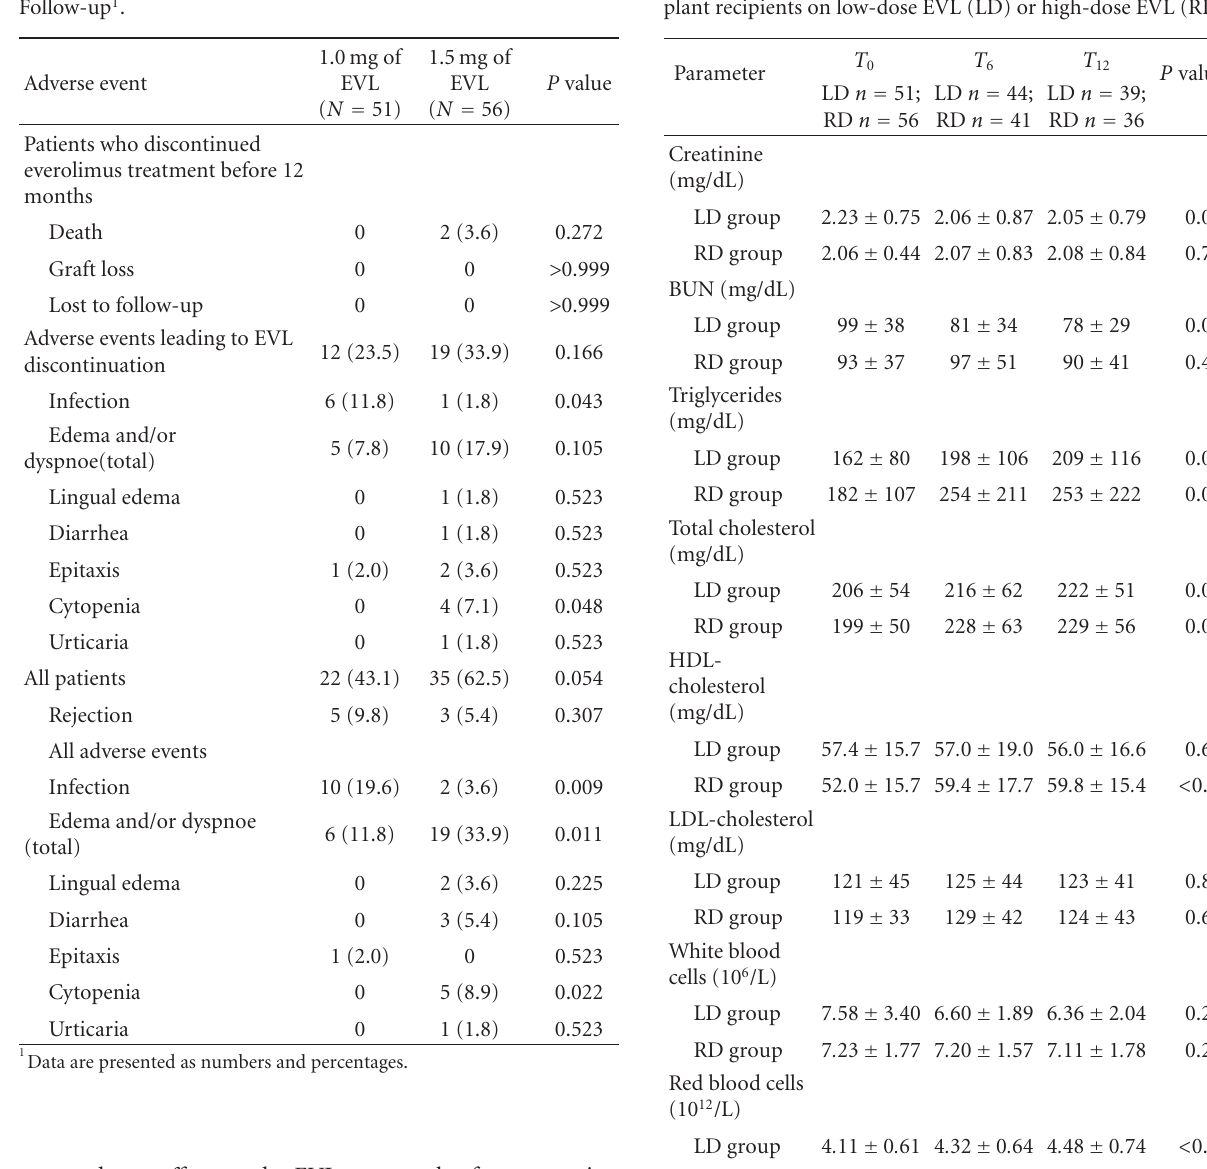
Table 4: Time course of biochemical paramters in cardiac